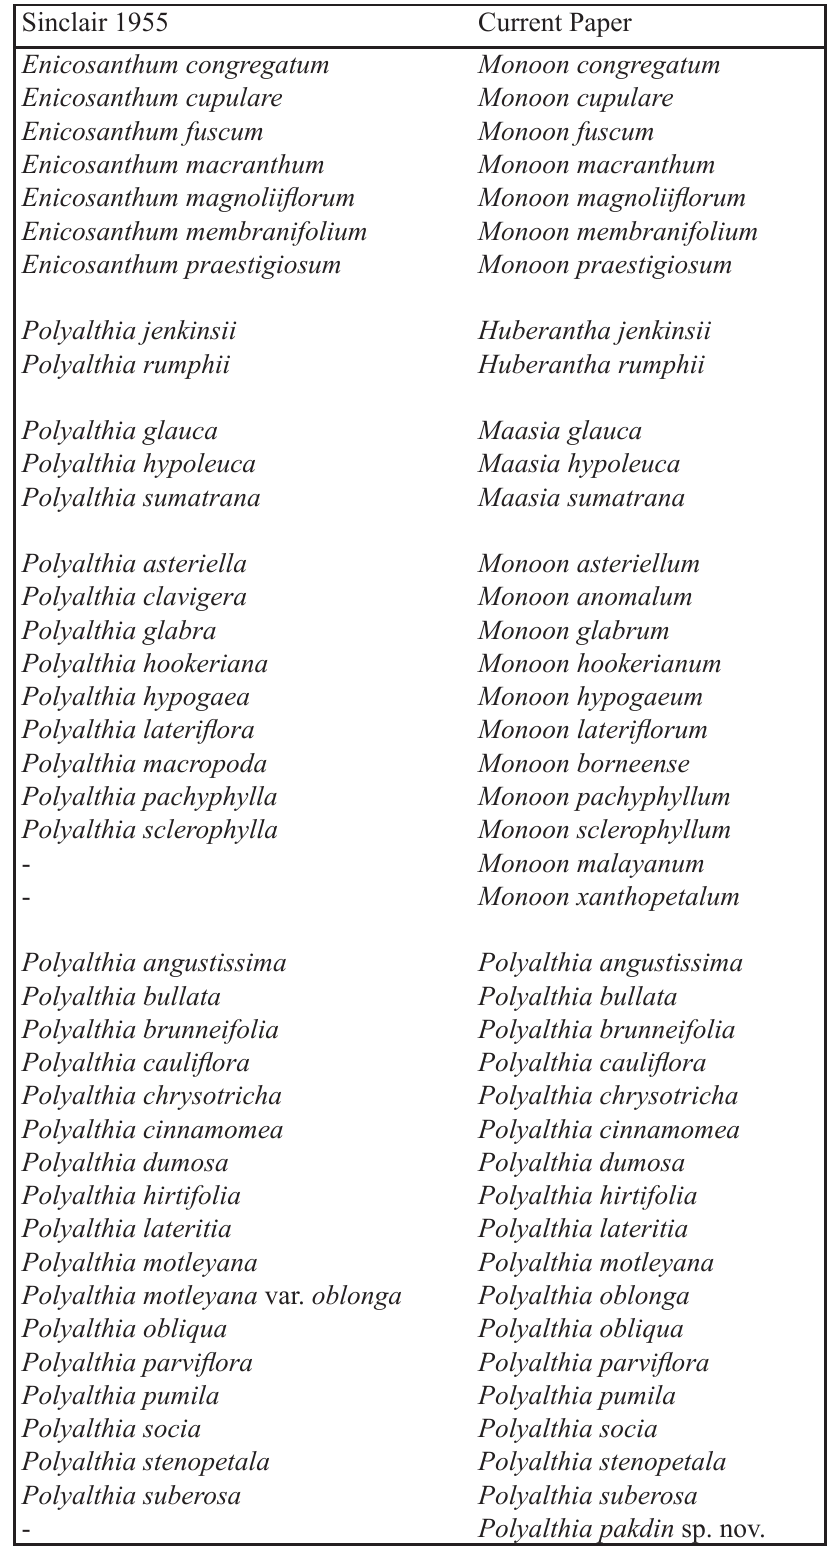
Table 1. Comparison of accepted names of species in Polyalthia sensu lato native to Peninsular Malaysia between Sinclair (1955) and the current